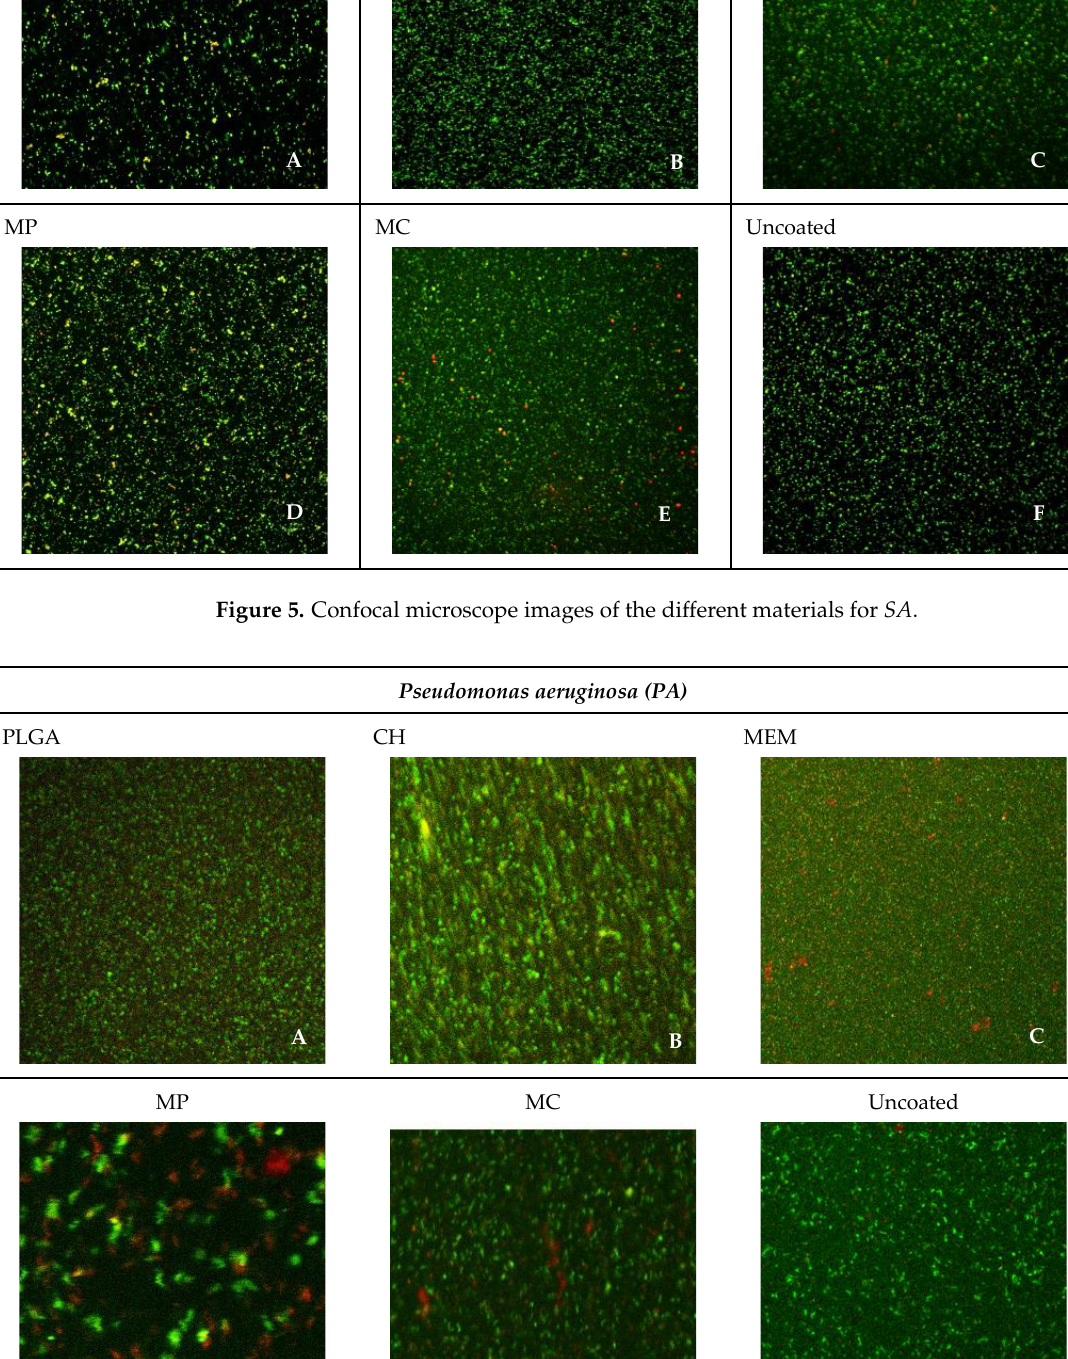
Figure 6. Confocal microscope images of the different materials for PA.